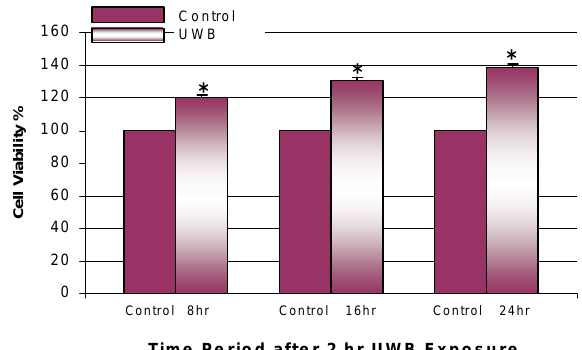
Figure 2: Mitogenic effect of UWBR on HGM-treated AML-12 mouse hepatocytes. HGM-treated AML-12 mouse hepatocytes were exposed to UWB pulses for 2 h at a temp of 23 o C, pulse width of 10 ns, repetition rate of 1 kHz, and applied field strength of 5-20 kV/m. Cell